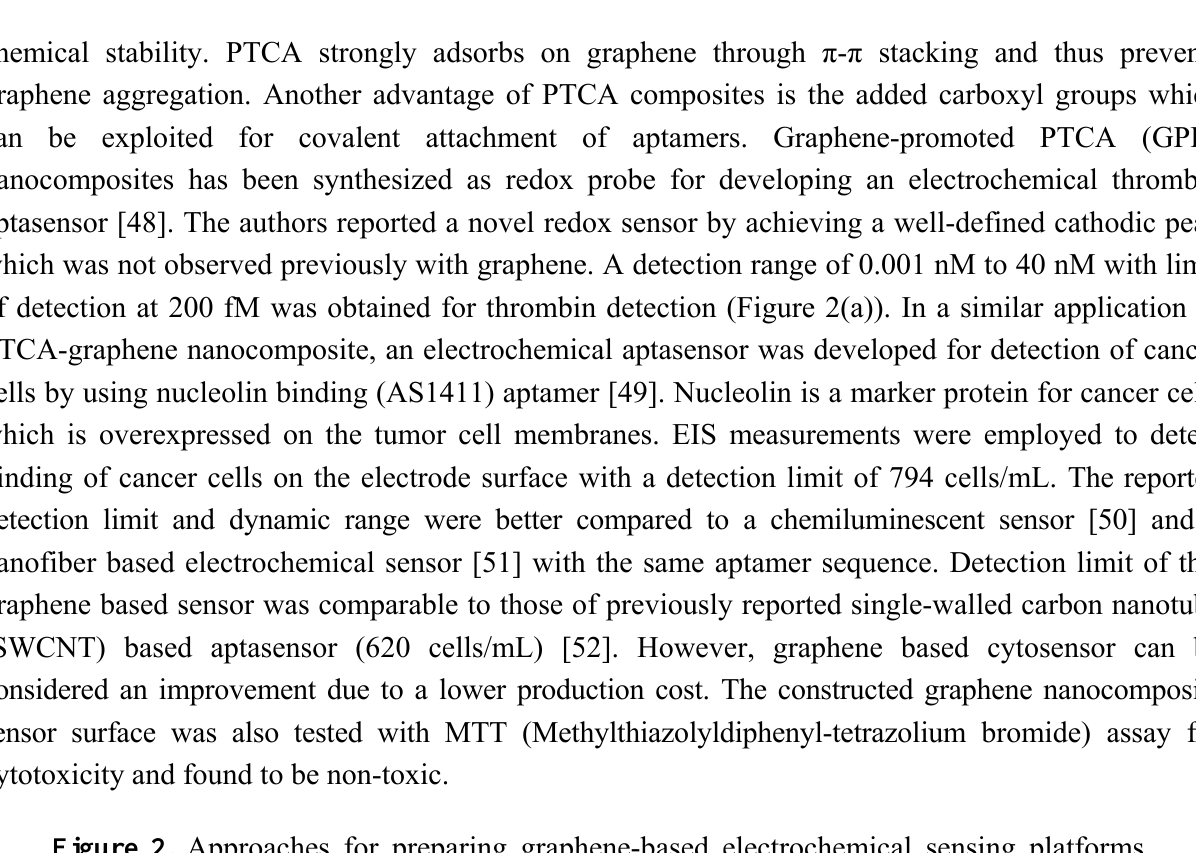
Figure 2. Approaches for preparing graphene-based electrochemical sensing